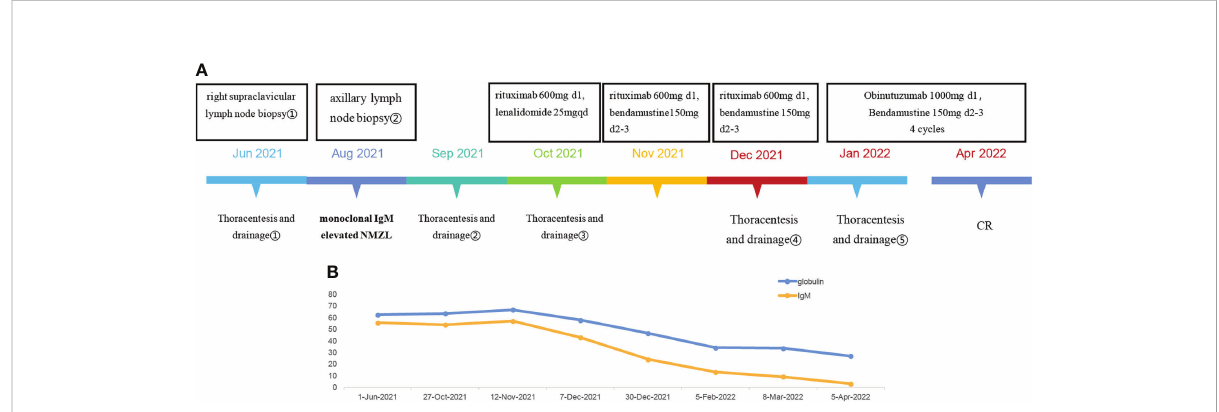
FIGURE 1 (A) The treatment timeline of this patient. (B) The decreasing trend of globulin and IgM in this patient during the inpatient and outpatient follow- up period from June 2021 to April